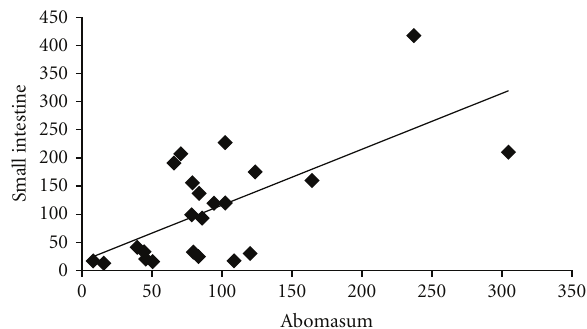
Figure 1: Relationship between concentrations of bradykinin (pg/mg protein) in abomasal mucus and the corresponding con- centration in small intestinal mucus. r = 0 . 66, P < 0 . 001.